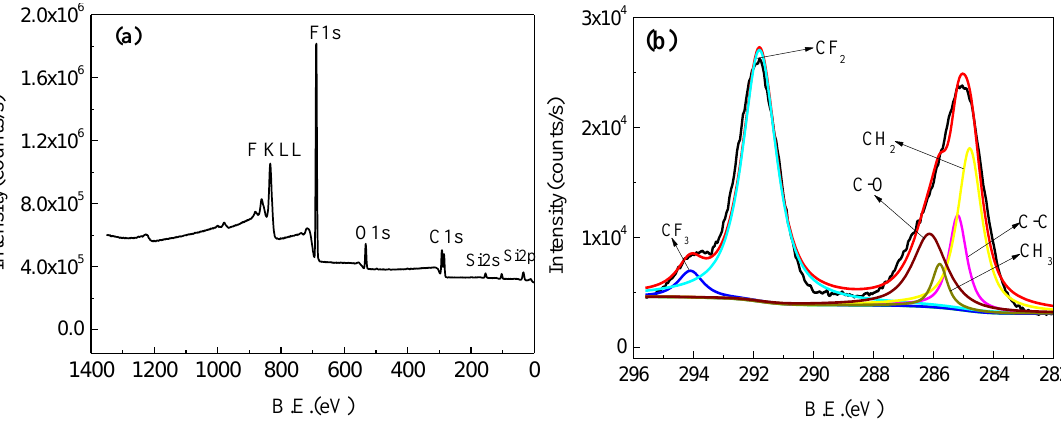
Figure 5. XPS spectra of conversion-coated 5052 aluminum alloy after FAS-17 modification: ( a ) the wide-scan spectrum, ( b ) C1s spectrum.